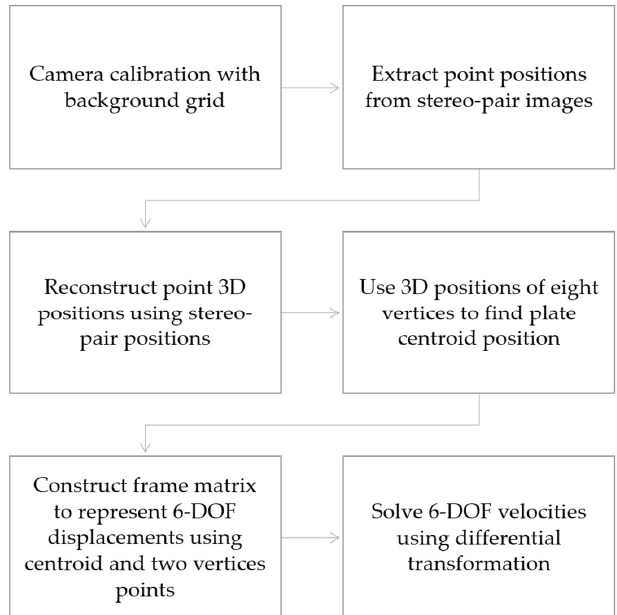
Figure 3. Flowchart of debris-tracking algorithm.